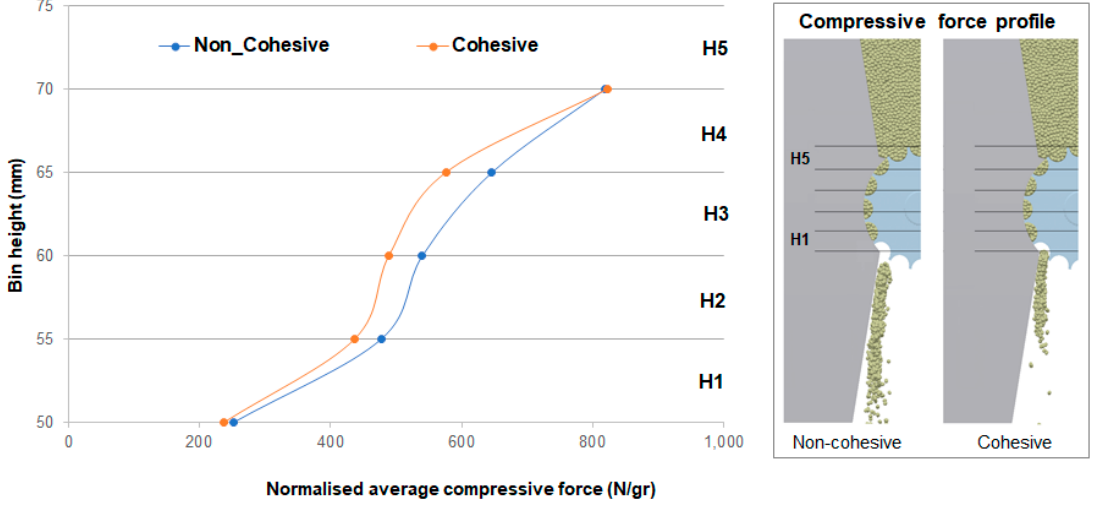
Figure 13. Profile of the average compressive force normalized against the mass of each particle cov- ering the vertical height of the wheel for the free-flowing (blue) and the cohesive (orange)